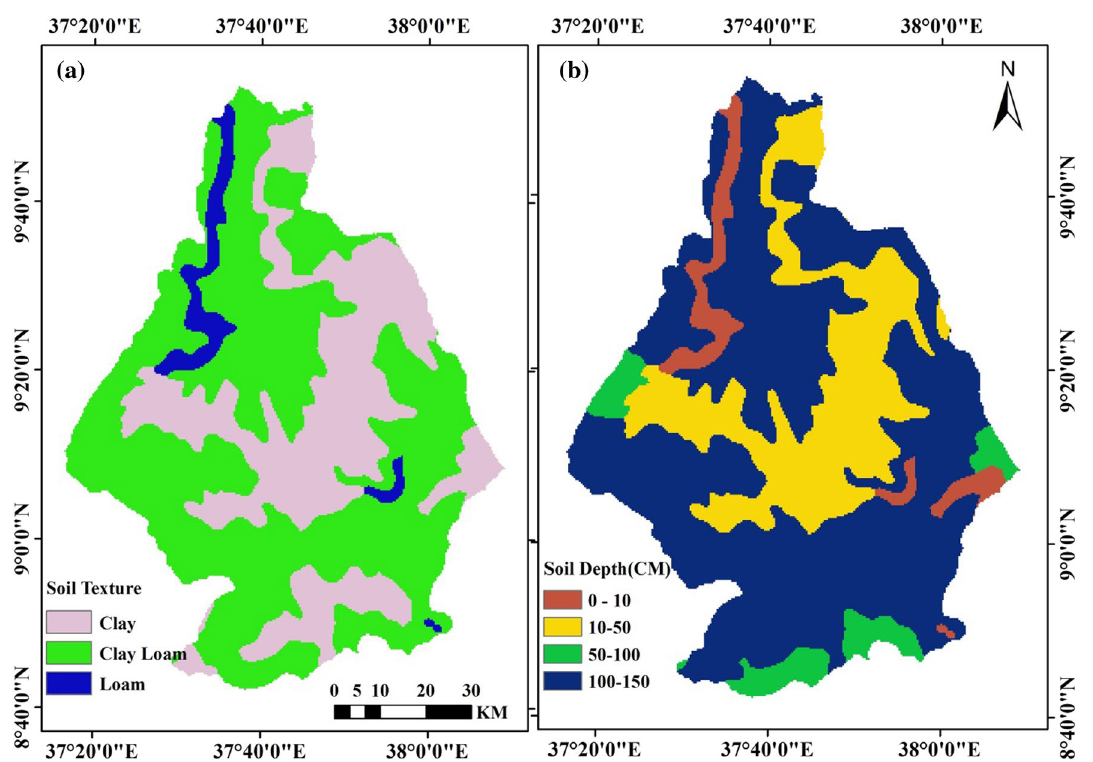
Fig. 3 a Soil texture, b soil depth (cm) map of Guder